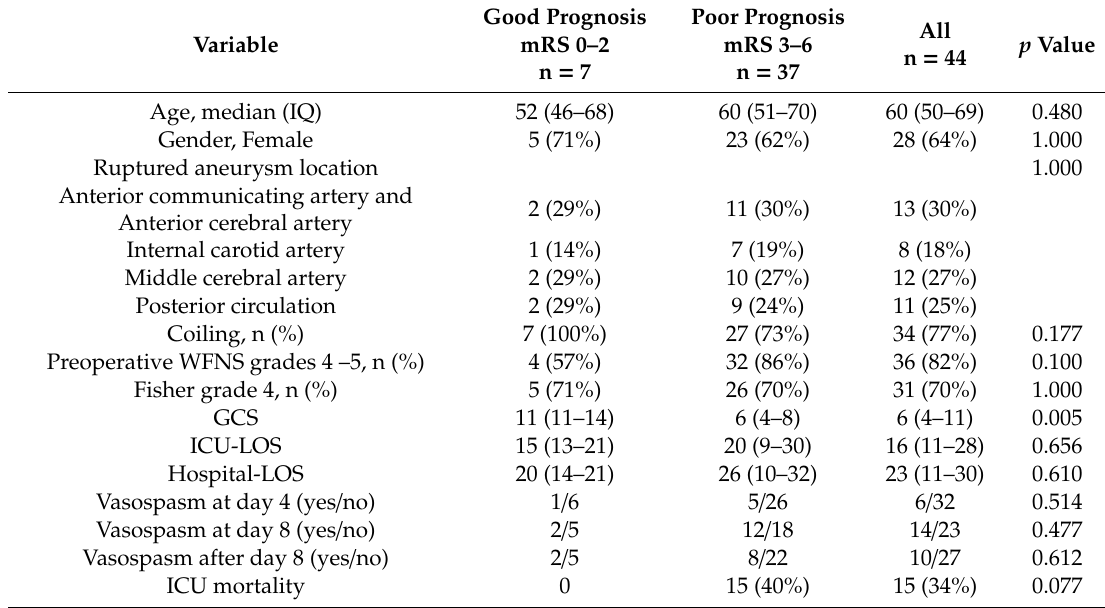
Table 1. Demographic and clinical characteristics of the 44 included